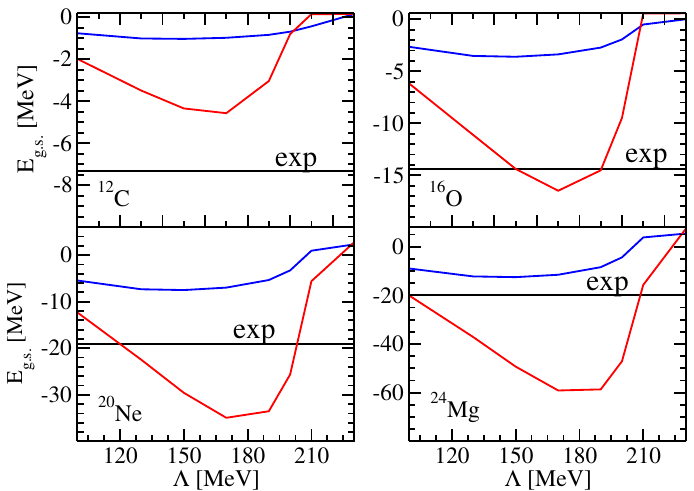
Figure 6: Cutoff dependence of ground-state energies of various α -nuclei with HH quantum number K equal to 12 ( 12 C , 16 O) and 8 ( 20 Ne, 24 Mg). Blue curves: λ attractive; red curves: λ 0